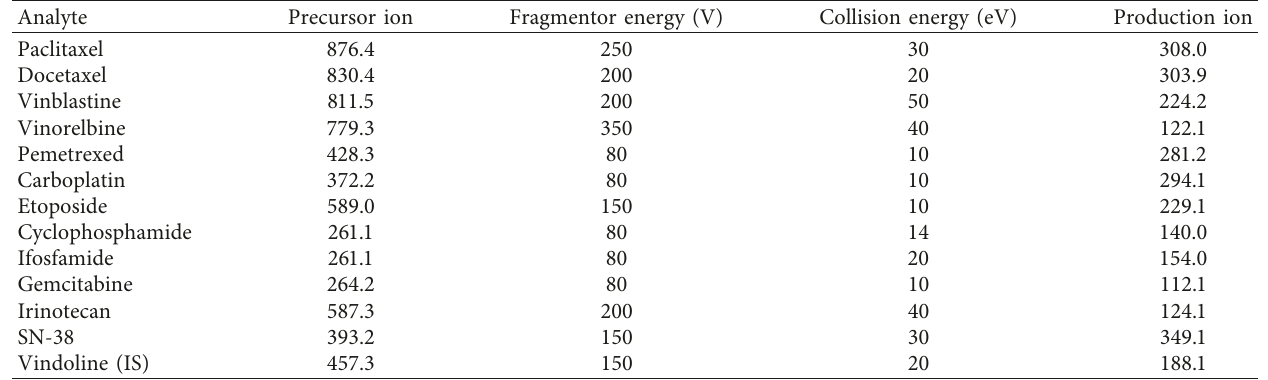
Table 1: Optimized multiple reaction monitoring parameters for the analytes and